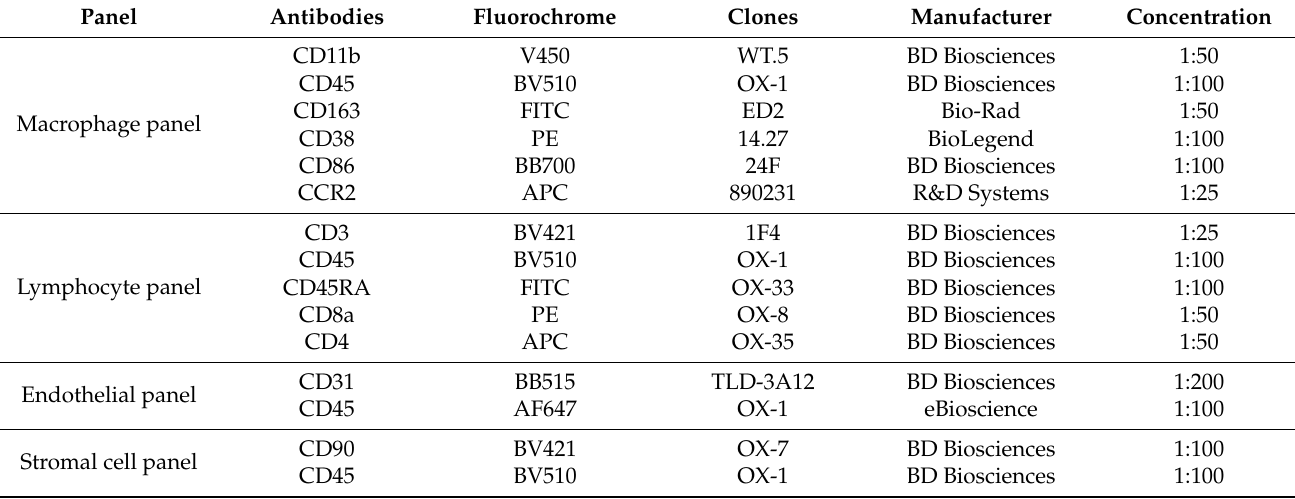
Table 2. Descriptions of panels including antibodies, fluorochromes, clones, manufacturer, and staining concentration.